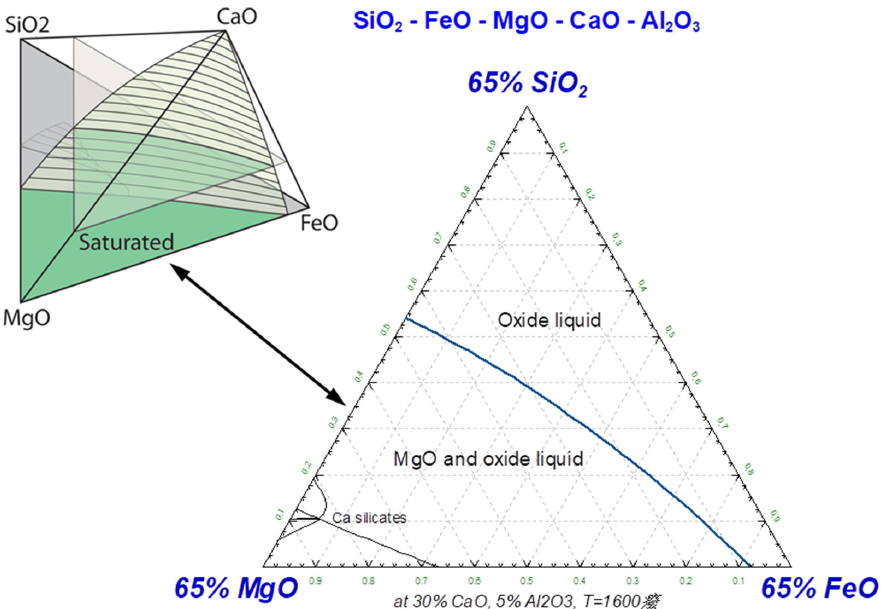
Figure 2. The calculated stability field of MgO periclase and Ca silicates on the pseudo-triangular plane at 30% CaO and 1600 °C in the system CaO–SiO 2 –FeO–MgO–5%Al 2 O 3 ; all calculations from Factsage™.